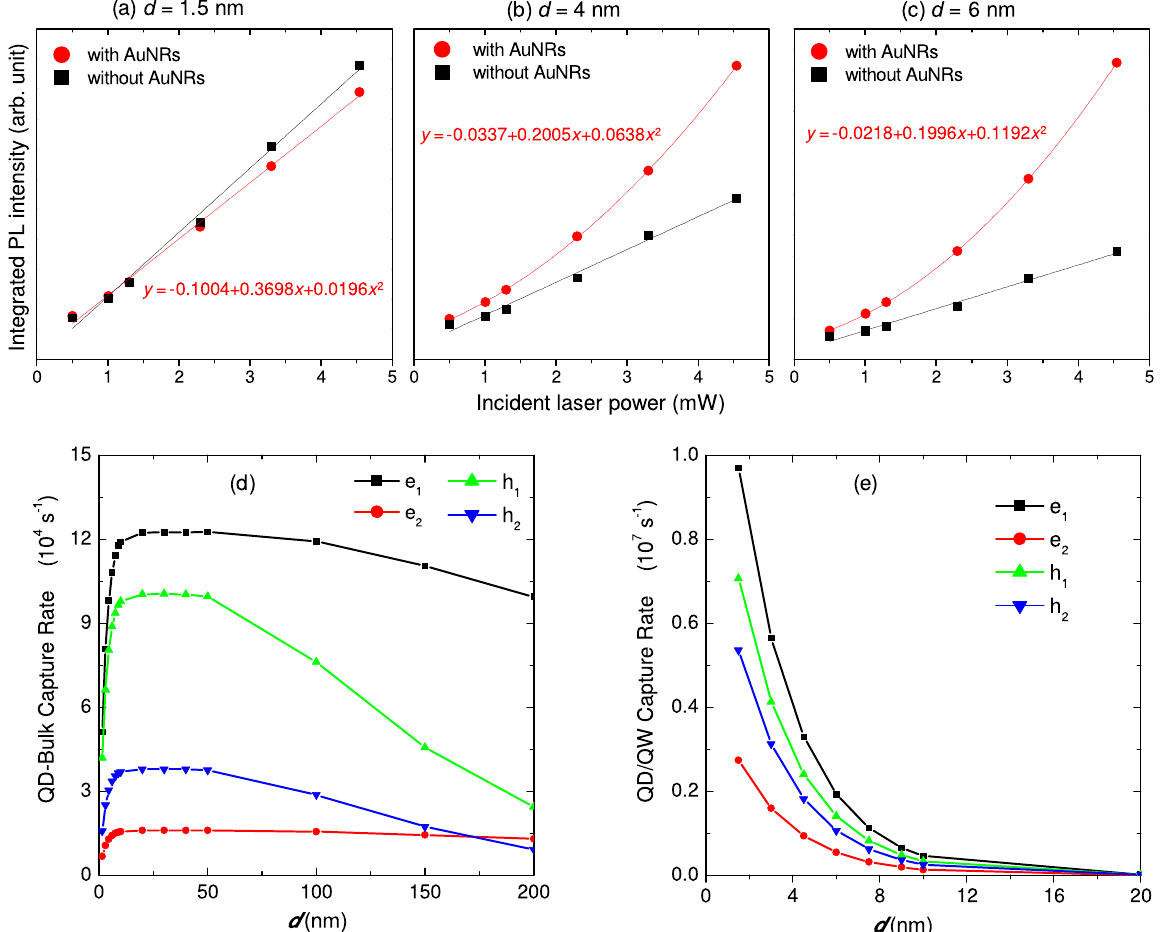
Figure 4. Incident laser power dependence and carrier diffusion. PL plotted as a function of laser power for GaAs thicknesses of ( a ) 1.5 nm, ( b ) 4 nm, and ( c ) 6 nm in the presence (red circles) and absence (black squres) of AuNRs. In the absence of the AuNRs, the PL intensity has a linear dependence on the incident power for all GaAs thicknesses. In the presence of the AuNRs, the intensity varies with laser power quadratically, and the degree of nonlinearity increases with the thickness of GaAs as can be seen by comparing the relative values of the coefficients of the linear and the quadratic terms in ( a ) to ( c ). ( d ) Calculated capture rates by two lowest electron ( e ) and hole ( h ) energy levels of a QD for electrons and holes generated inside GaAs as a function of d (GaAs thickness). ( e ) Calculated distance dependence of capture rates by two lowest QD electron and hole levels generated inside the InGaAs quantum well (the trend shows near-field enhanced electron-hole generation inside